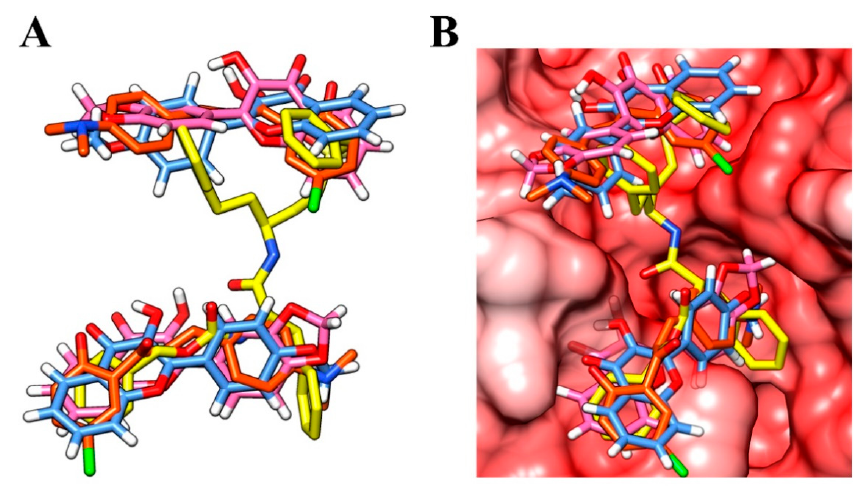
Figure 4. ( A ) Overlay of the vinyl sulphone analogue (yellow), compound 3c (orange), f12a (blue), and f12b (pink); ( B ) the compounds overlaid at the binding site of the enzyme. The isoforms rCPB2.8, rCPB3, and rH84Y have a small number of modifications in their active sites (Table S1, Supplementary Material). However, the few amino-acid